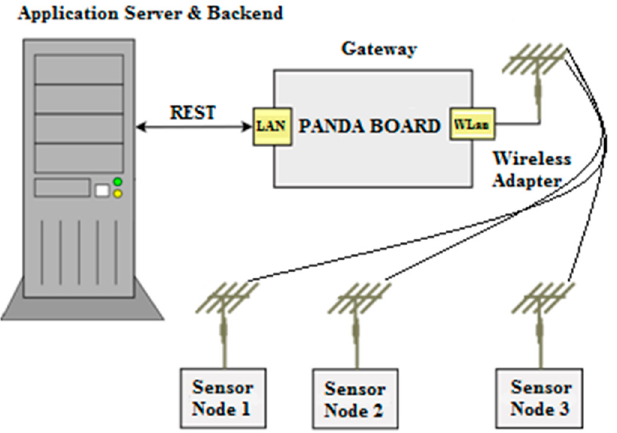
Figure 28. Main components of the network.